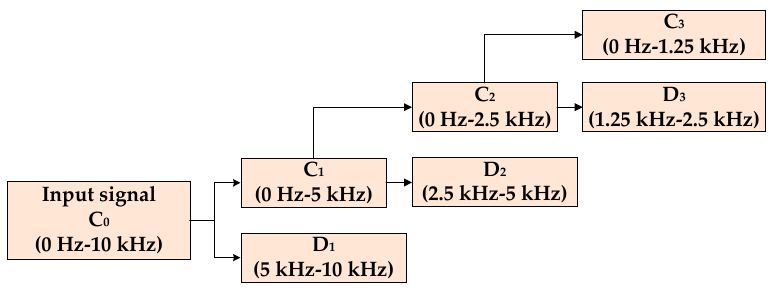
Figure 8. The analytic bandwidth of 3-layer DWT .